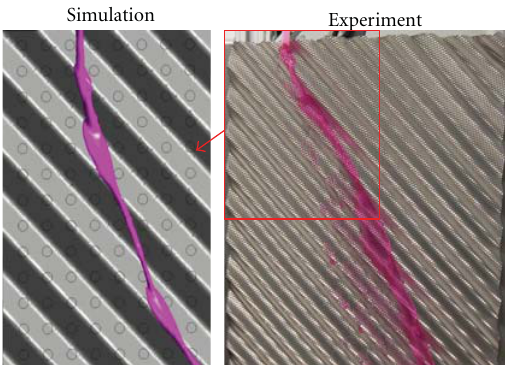
Figure 9: Comparison between simulation and experiment for flow of water-glycerol on corrugated sheet of packing without holes. Flow rate: 387 mL/min.